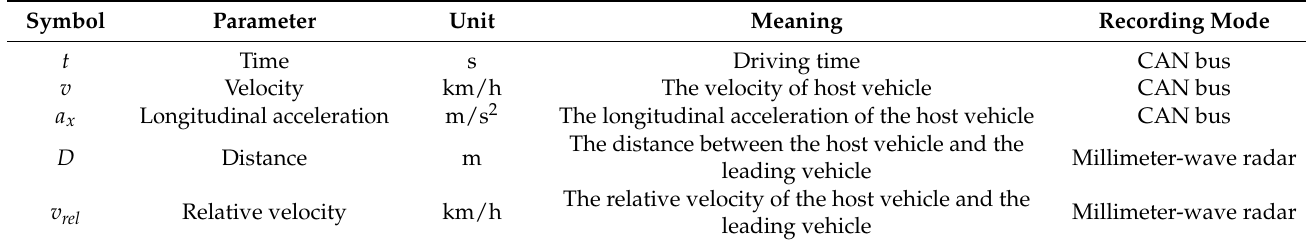
Table 1. Input parameters of the model.